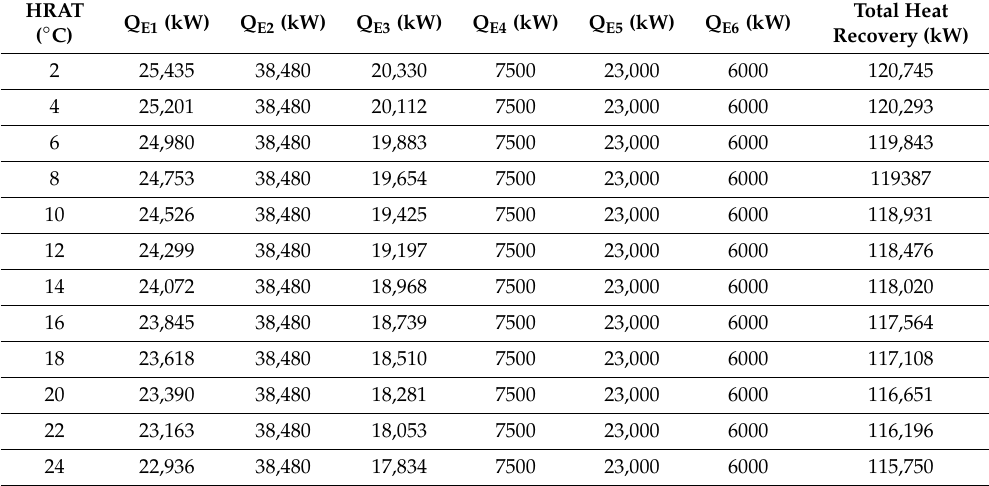
Table A4. Exchangers heat duties for HEN at di ff erent heat recovery approach temperature (HRAT) values using option 1.